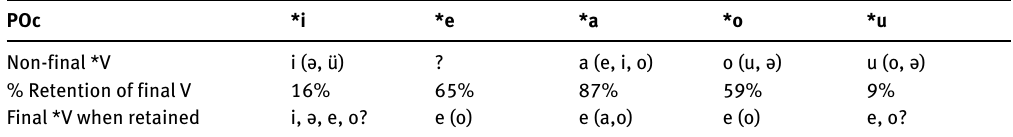
Table 5: Ninde reflexes of POc final